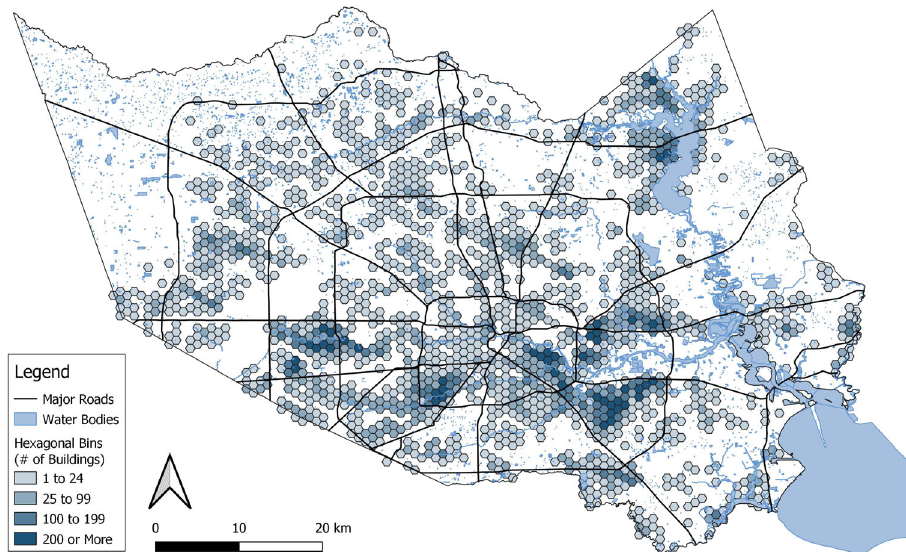
Fig. 1 Map of climate change-attributed fl ooding (38% scenario). Each hexagonal bin symbolizes the number of residential buildings that would not have fl ooded without the added impact of climate change in Harris County, Texas during Hurricane